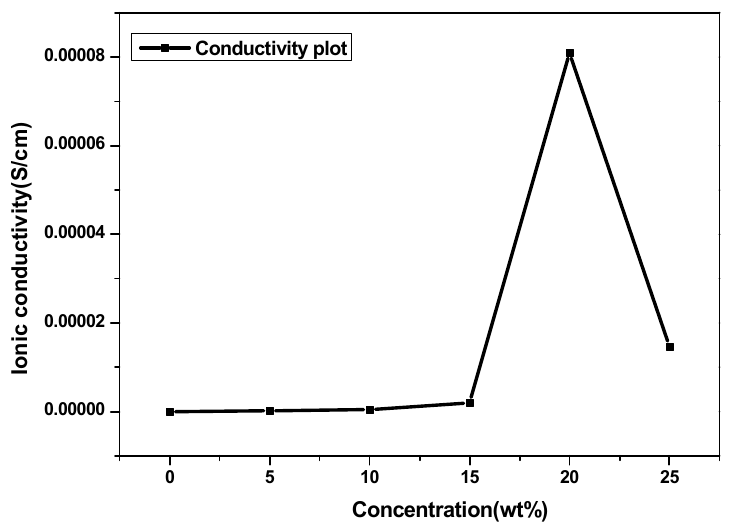
Figure 6. Dependence of conductivity with the concentration of NaSCN in PVA: PVP (50:50 wt%) PE.